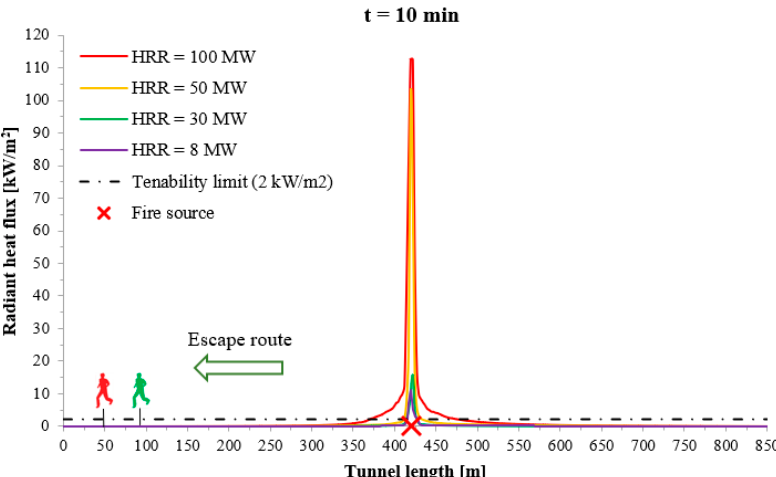
Figure 4. Longitudinal radiant heat flux profiles (t = 10 min) at a height of 2 m along the escape path when the fire source is in the middle of the tunnel length.